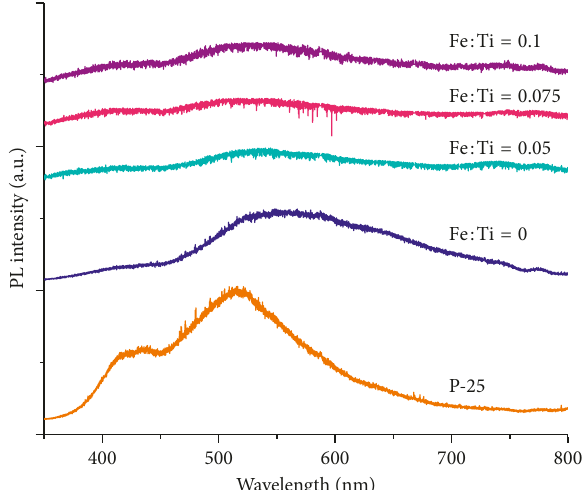
Figure 6: PL measurements of TiO Fe 3+ :Ti molar